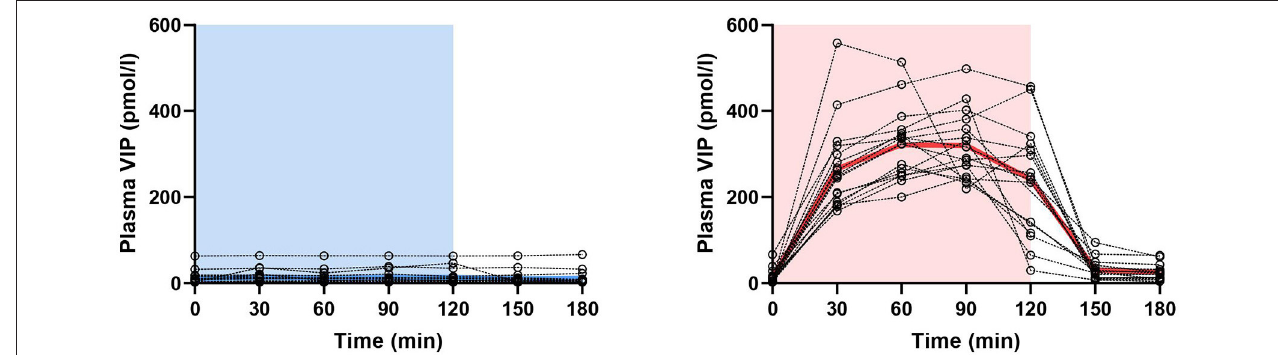
FIGURE 1 | Changes in plasma concentration of vasoactive intestinal polypeptide (VIP) during and after 2-h infusion of placebo ( p = 0.240) or VIP ( p < 0.001) in patients with migraine. The light blue area represents placebo infusion, while the red area represents VIP infusion. Dotted lines represent individual values, while thick lines show mean